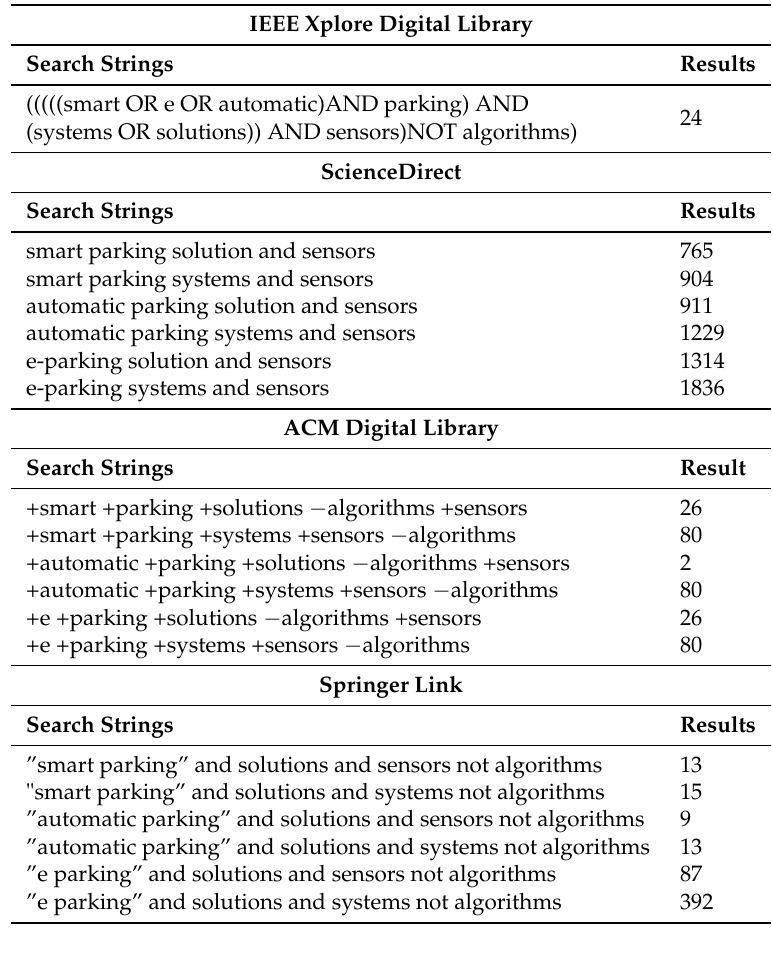
Table 2. IEEE Xplore Digital Library, ScienceDirect, ACM Digital Library, and Springer query results for extra